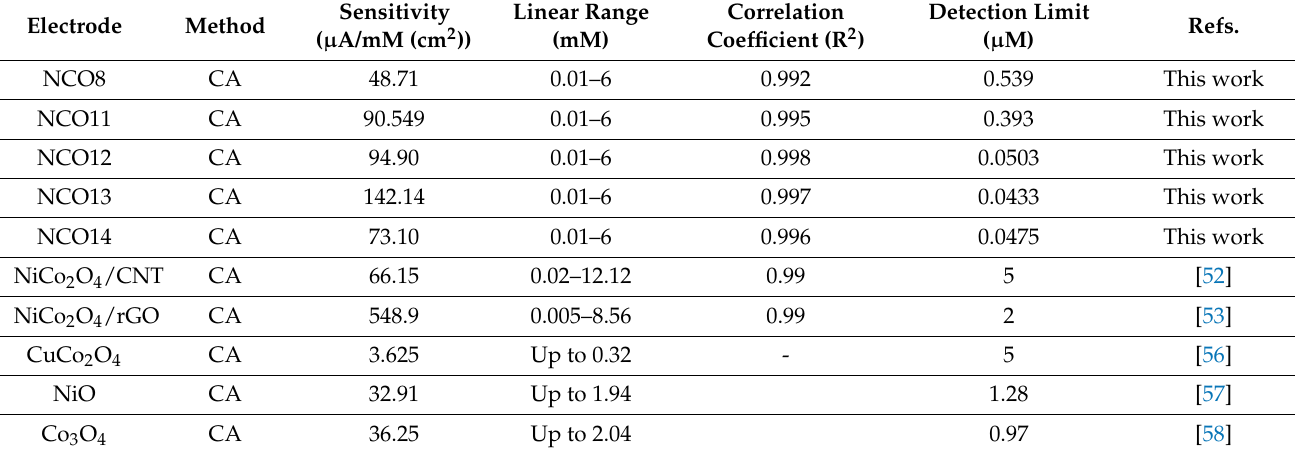
Table 1. Comparison of our work to the nonenzymatic glucose